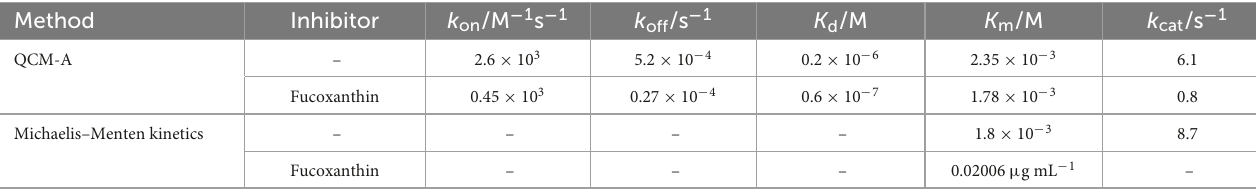
TABLE 1 Kinetic parameters of the endo-type hydrolysis of amylose by α -amylase.